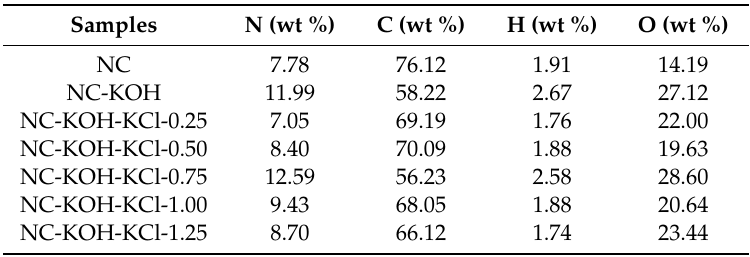
Table 1. The content of N, C, H and O in samples activated by different amount of KCl and 1.2 g KOH per 2.20 g resorcinol.